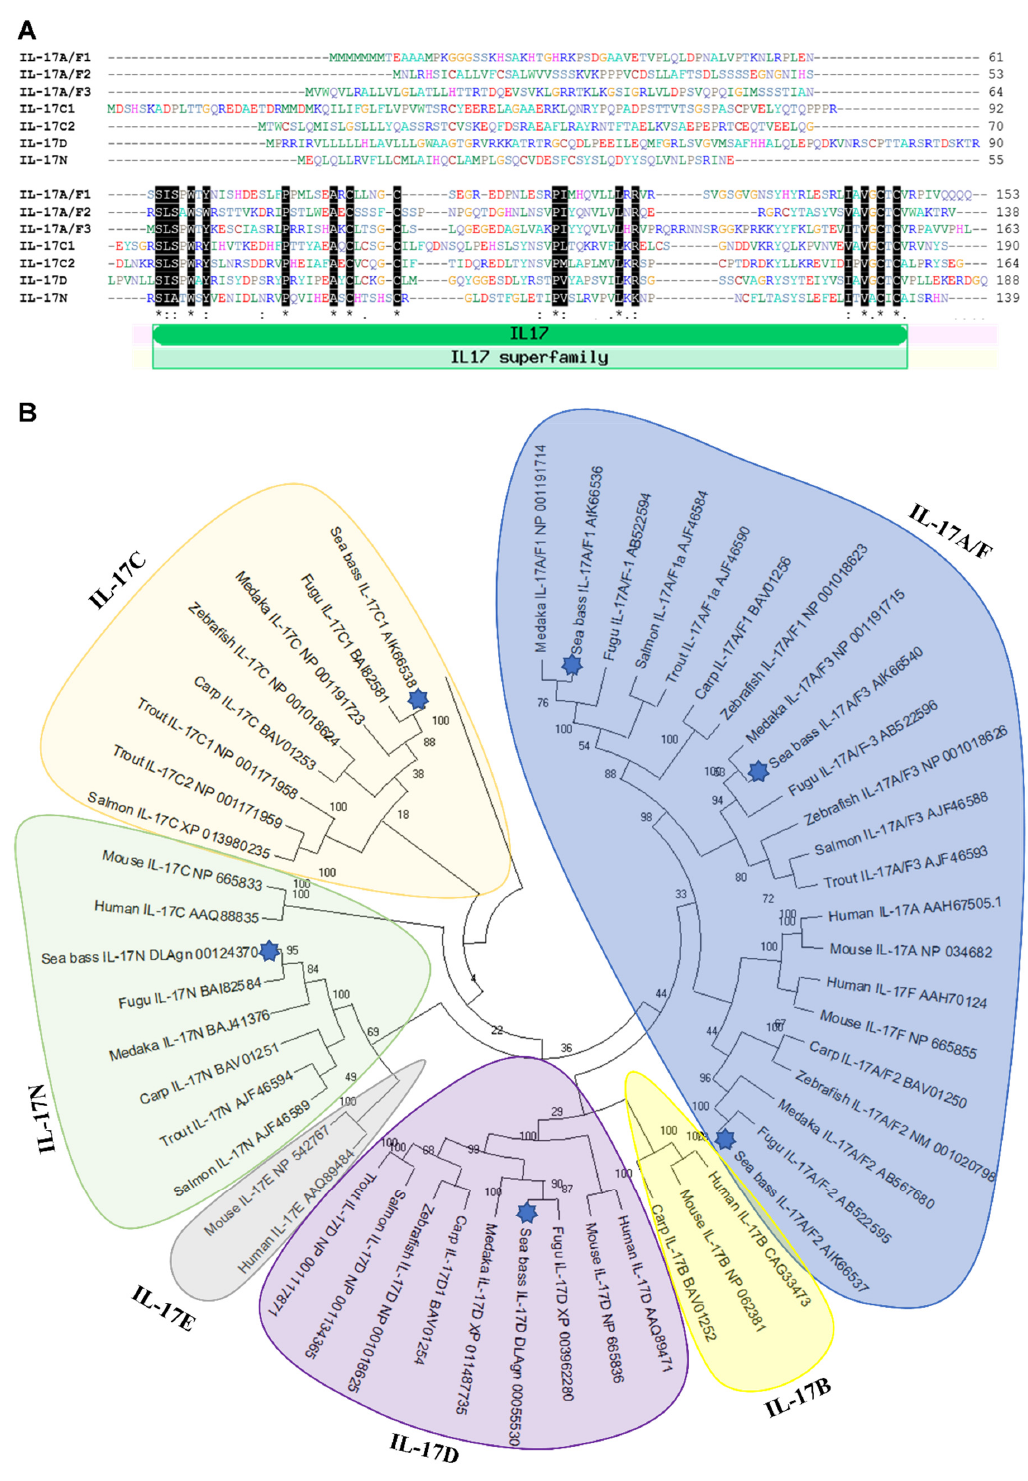
Figure 1. Identification of seven IL-17 ligands in European sea bass. ( A ) The predicted amino acid sequences of European sea bass IL-17 were aligned by ClustalW. The dashes denote gaps introduced to maximize alignments. Identical and similar residues are indicated by asterisks and colons, respectively. The position of the IL-17 domain is indicated. ( B) The neighbour-joining tree of the European sea bass IL-17 deduced proteins with fish and mammalian orthologues. The genetic distances were calculated based on protein di ff erences (p-distance) with complete deletion of gaps. The number at each node indicates the percentage of bootstrapping after 1000 replications. Accession numbers are